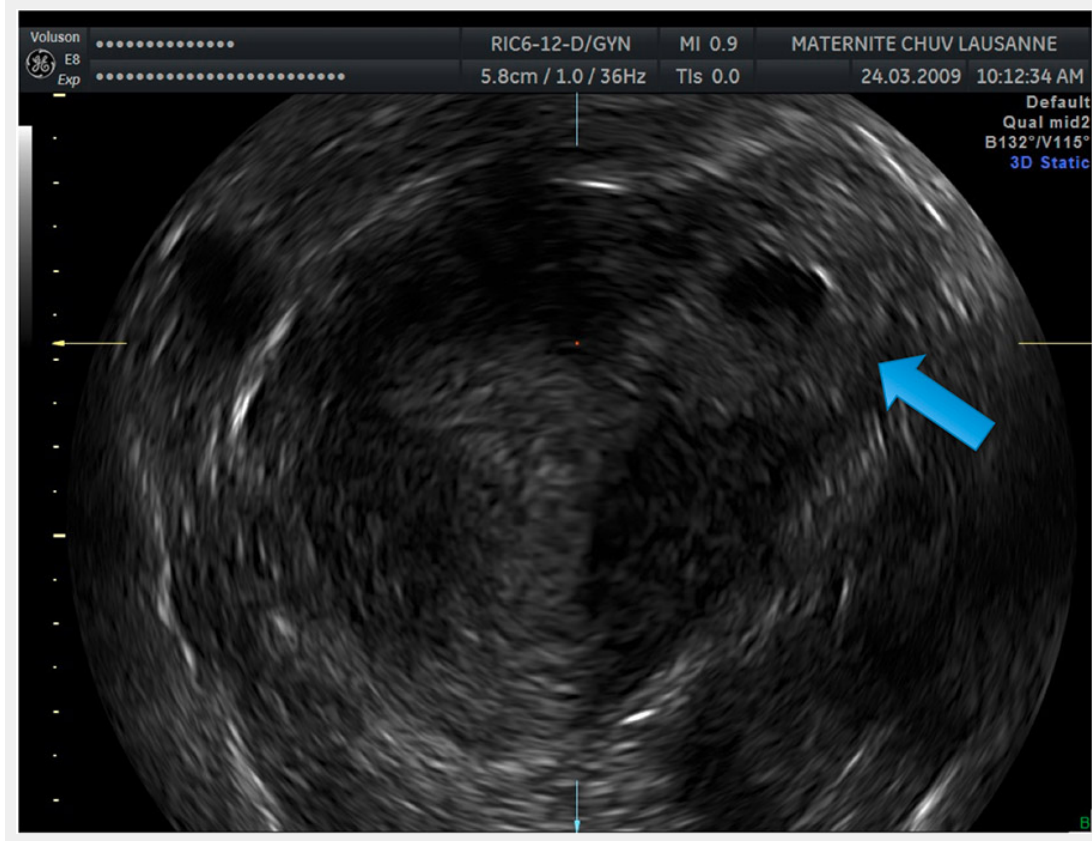
Figure 4 Image showing a left IP 3D reconstruction in a coronal sectional plane. The blue arrow indicates the lateral GS surrounded by a thin myometrial